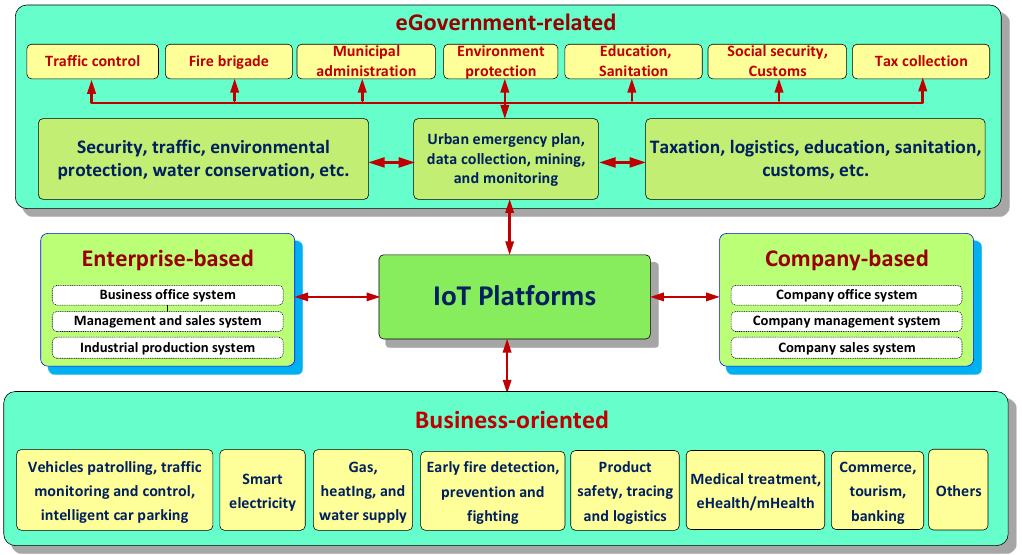
Figure 2. The IoT platform